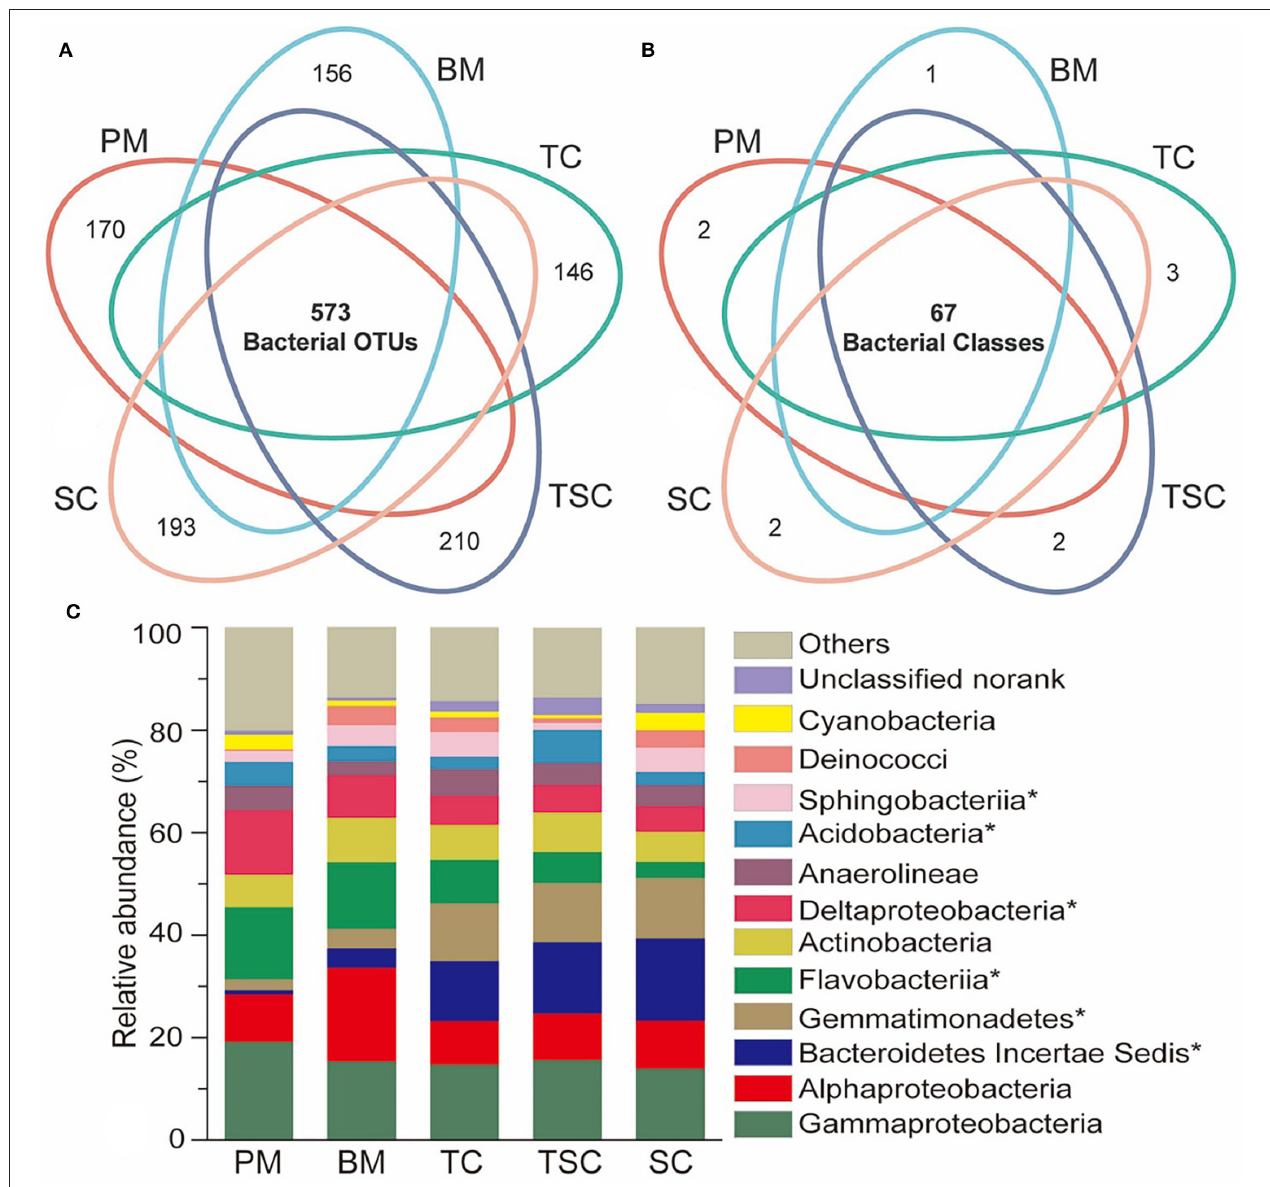
FIGURE 3 | Venn diagram of bacterial OTUs (A) and classes (B) among the five habitats. (C) Dominant bacteria in the five habitats at bacterial class level, and the asterisks (*) indicate the significantly different bacteria ( p <